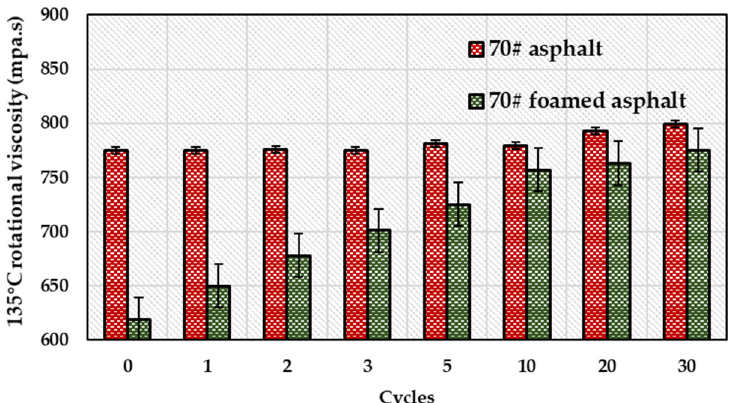
Figure 6. 135 °C rotational viscosity test results of samples with high-temperature evaporation cycles.